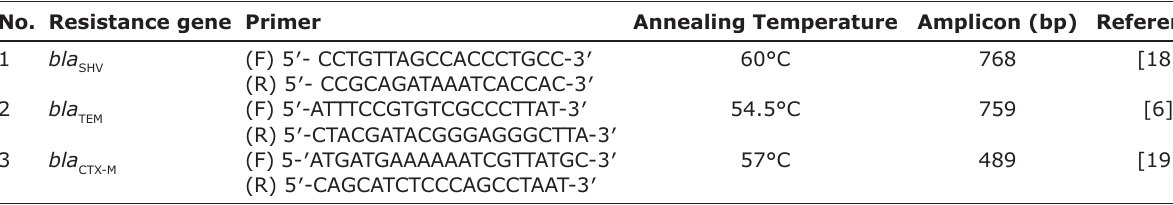
Table-1: Primers sets for detection of ESBL encoding genes from Klebsiella pneumoniae . No. Resistance gene Primer